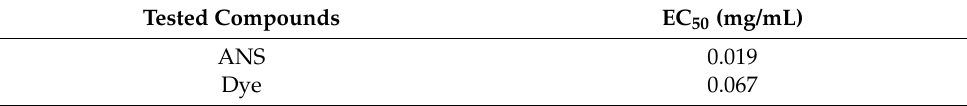
Table 3. Cytotoxicity of the ANS substrate and the dye expressed as IC 50 (mg/mL) after 24 h using colon epithelial cells and fibroblasts tested with LDH and MTT